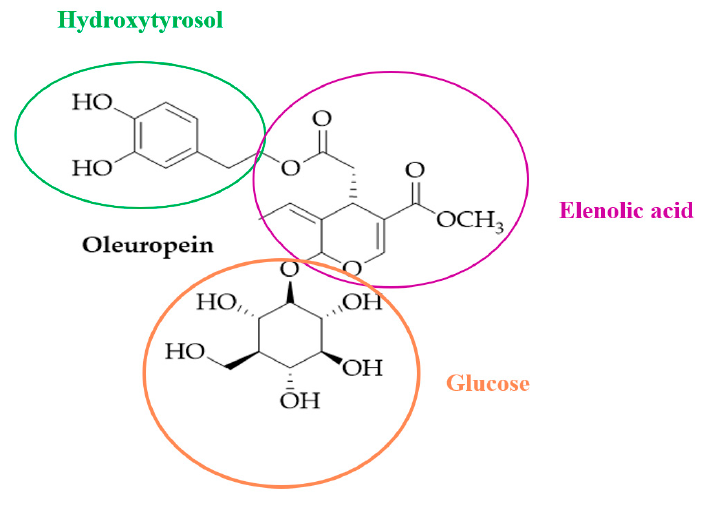
Figure 1. Chemical structure of oleuropein.